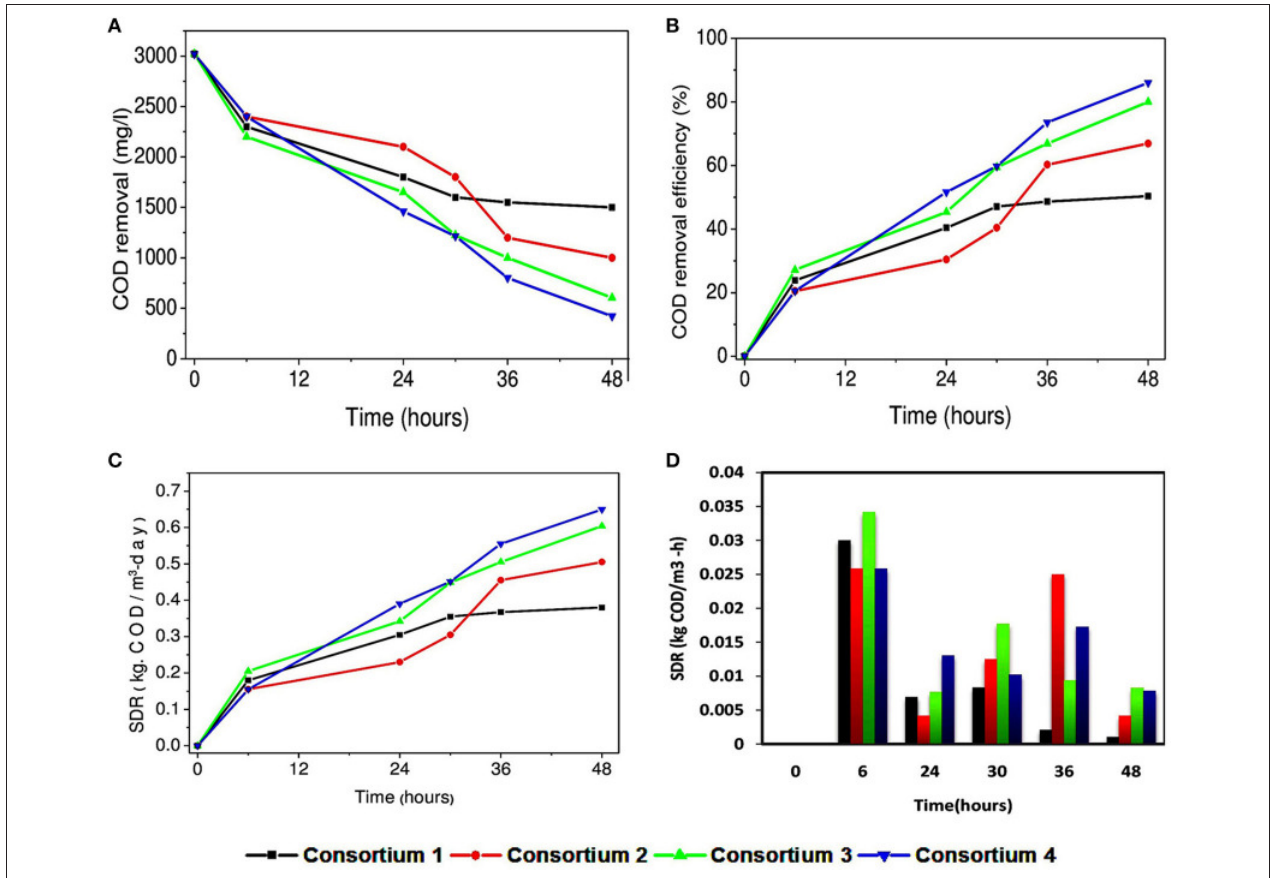
FIGURE 8 | (A) Variation in COD concentration removal (mg/l), (B) COD removal efficiency (%) with synthetic consortia. (C) Variation in substrate degradation rate (cumulative) (kg · COD R /m 3 -day) and (D) Substrate degradation rate (non-cumulative) (kg · COD T /m 3 -h) with synthetic